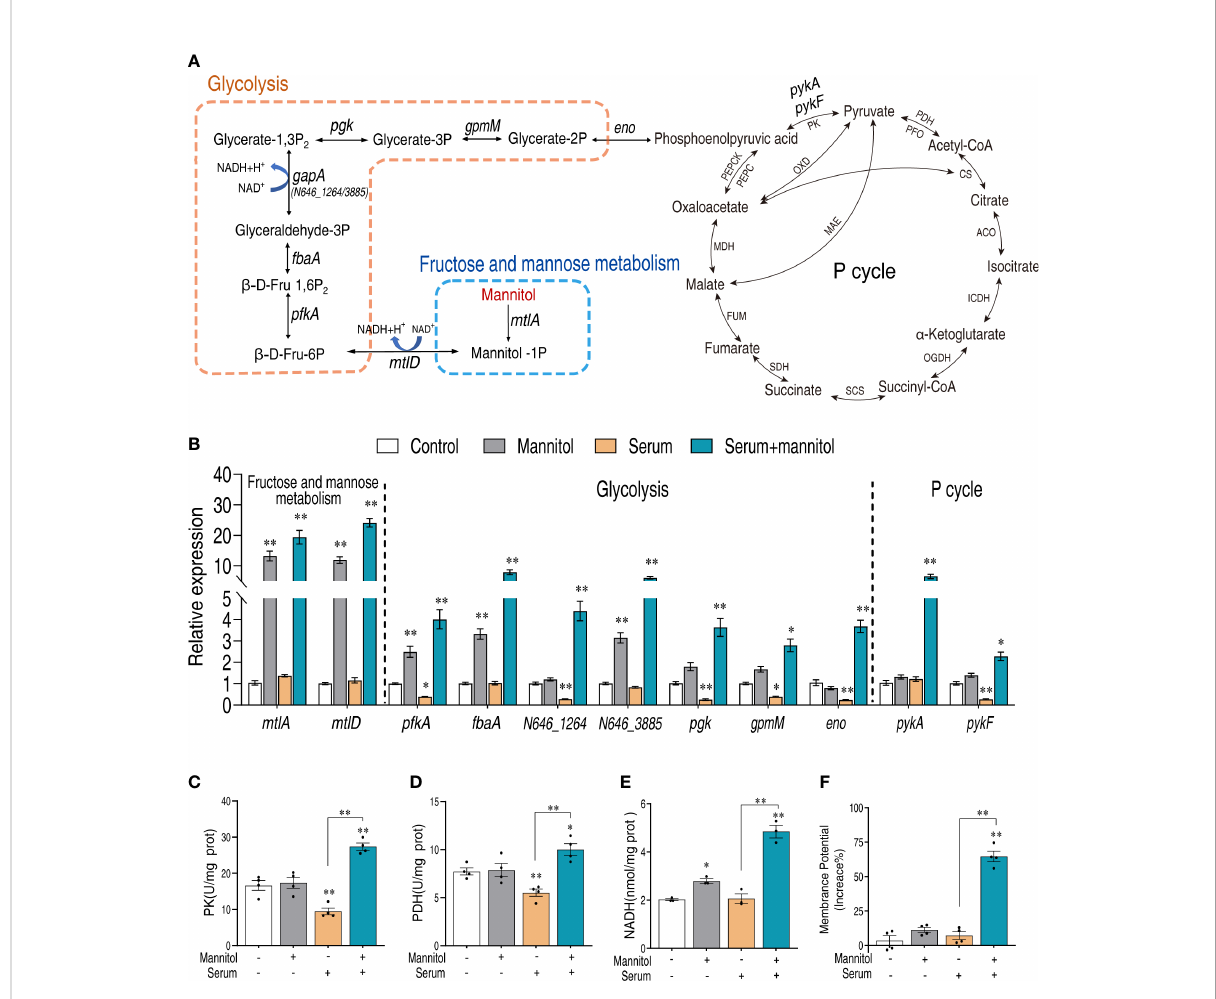
FIGURE 6 Mannitol promotes glycolysis and the pyruvate cycle. (A) Mannitol metabolism pathway. (B) Real-time quantitative reverse transcription-PCR (qRT-PCR) for the quanti fi cation of gene expression of glycolysis and P cycle. (C, D) Activity of pyruvate kinase and pyruvate dehydrogenase in the presence of mannitol or/and serum. (E) Effects of mannitol or/and serum on the content of NADH. (F) Membrane potential of Vibrio alginolyticus treated with 100 m l serum for 2 h in the presence or absence of 5 mM mannitol. The results are displayed as means ± SEM, and signi fi cant differences are identi fi ed (* p < 0.05 and ** p < 0.01) as determined by Student ’ s t -test. At least three biological repeats were carried